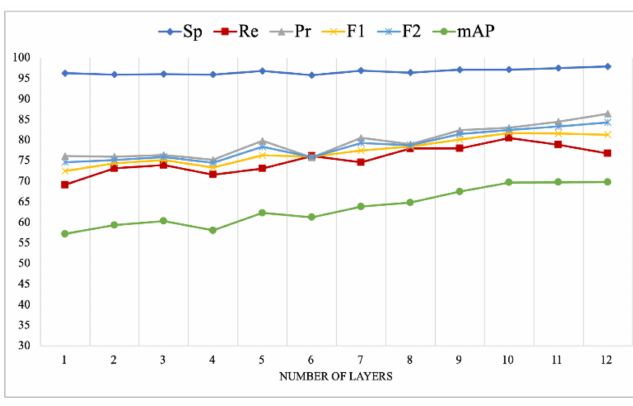
Figure 5. Results of our model on the Civezzano multi-label